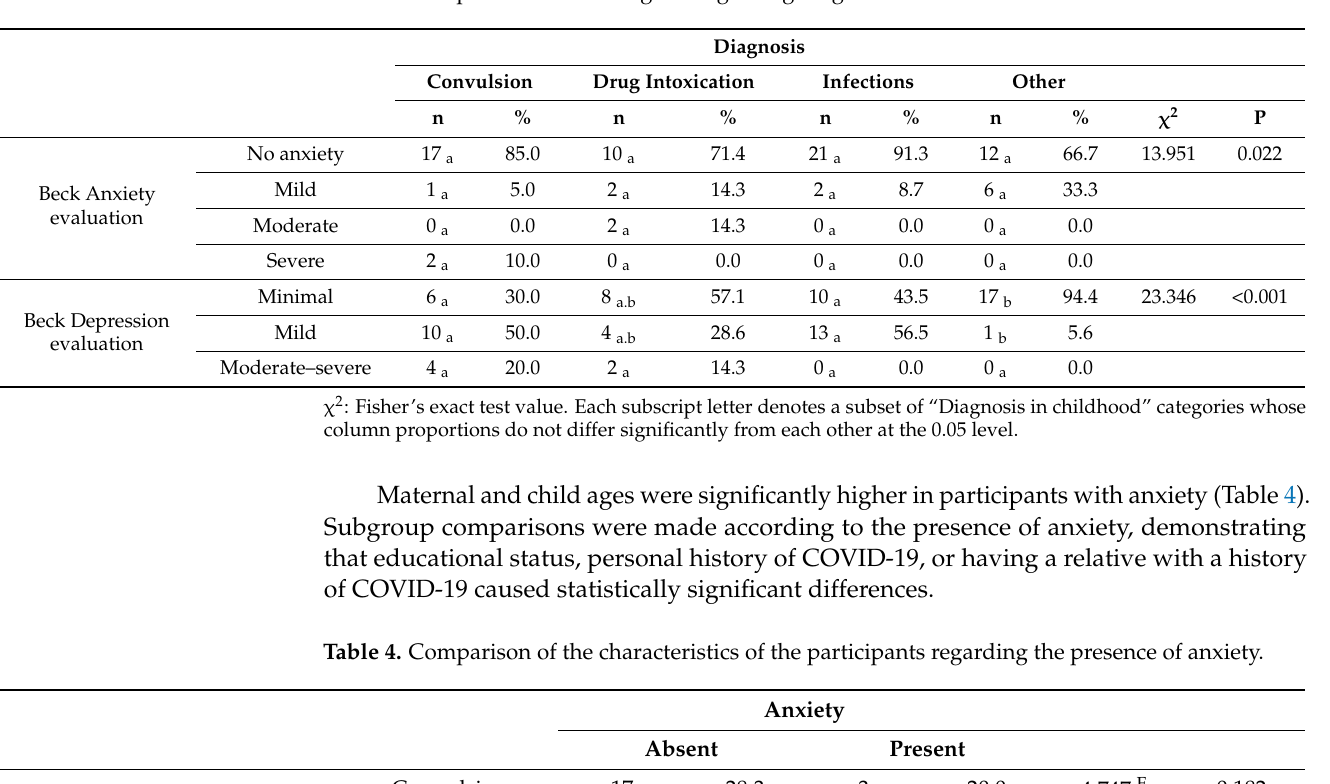
Table 3. Comparison of scale degrees regarding diagnosis.